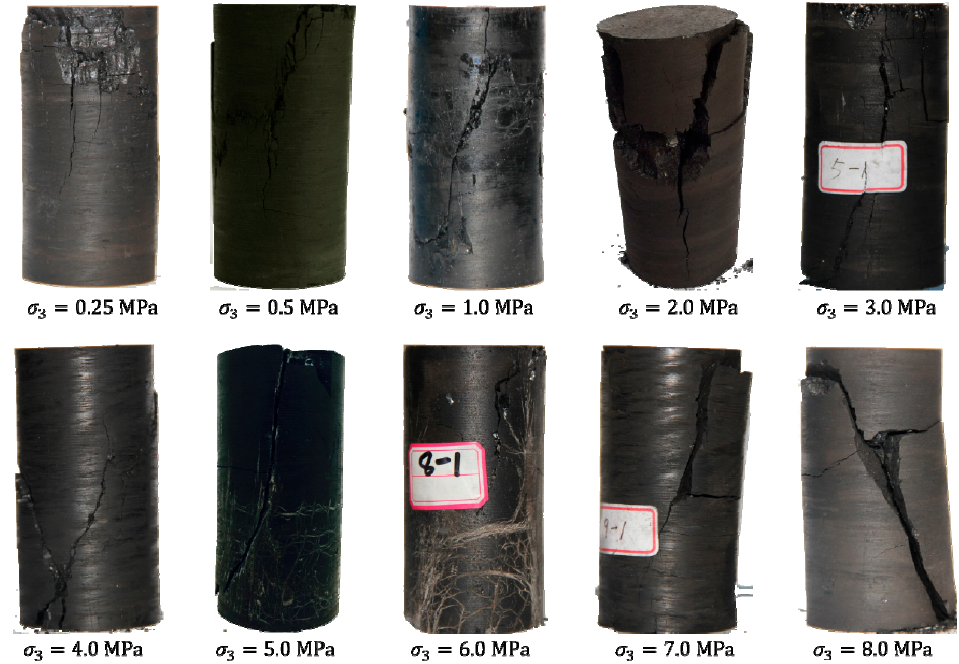
Figure 8. Failure pattern evolution with the increase of confining stress.